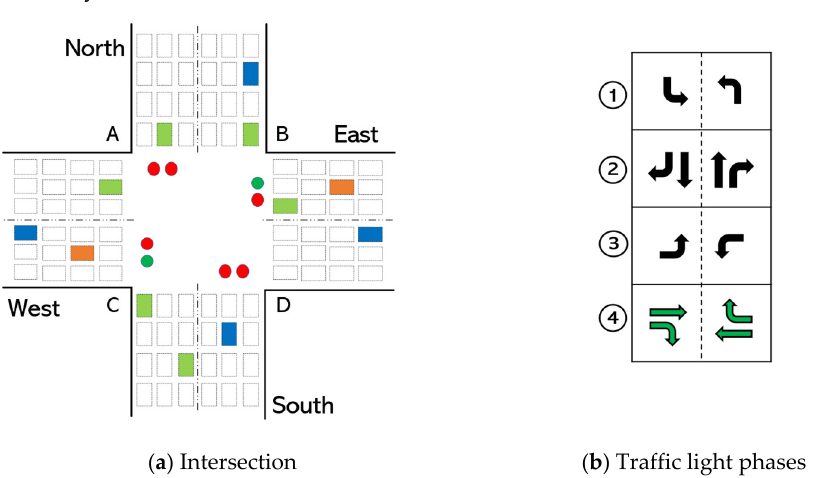
Figure 2. The illustration of ( a ) a road intersection that has four directions and twelve traffic move- ments, and ( b ) four traffic signal phases. Here, phase #4 is set for an intersection. The phase order is set cyclic as #1-2-3-4-1-2, etc.